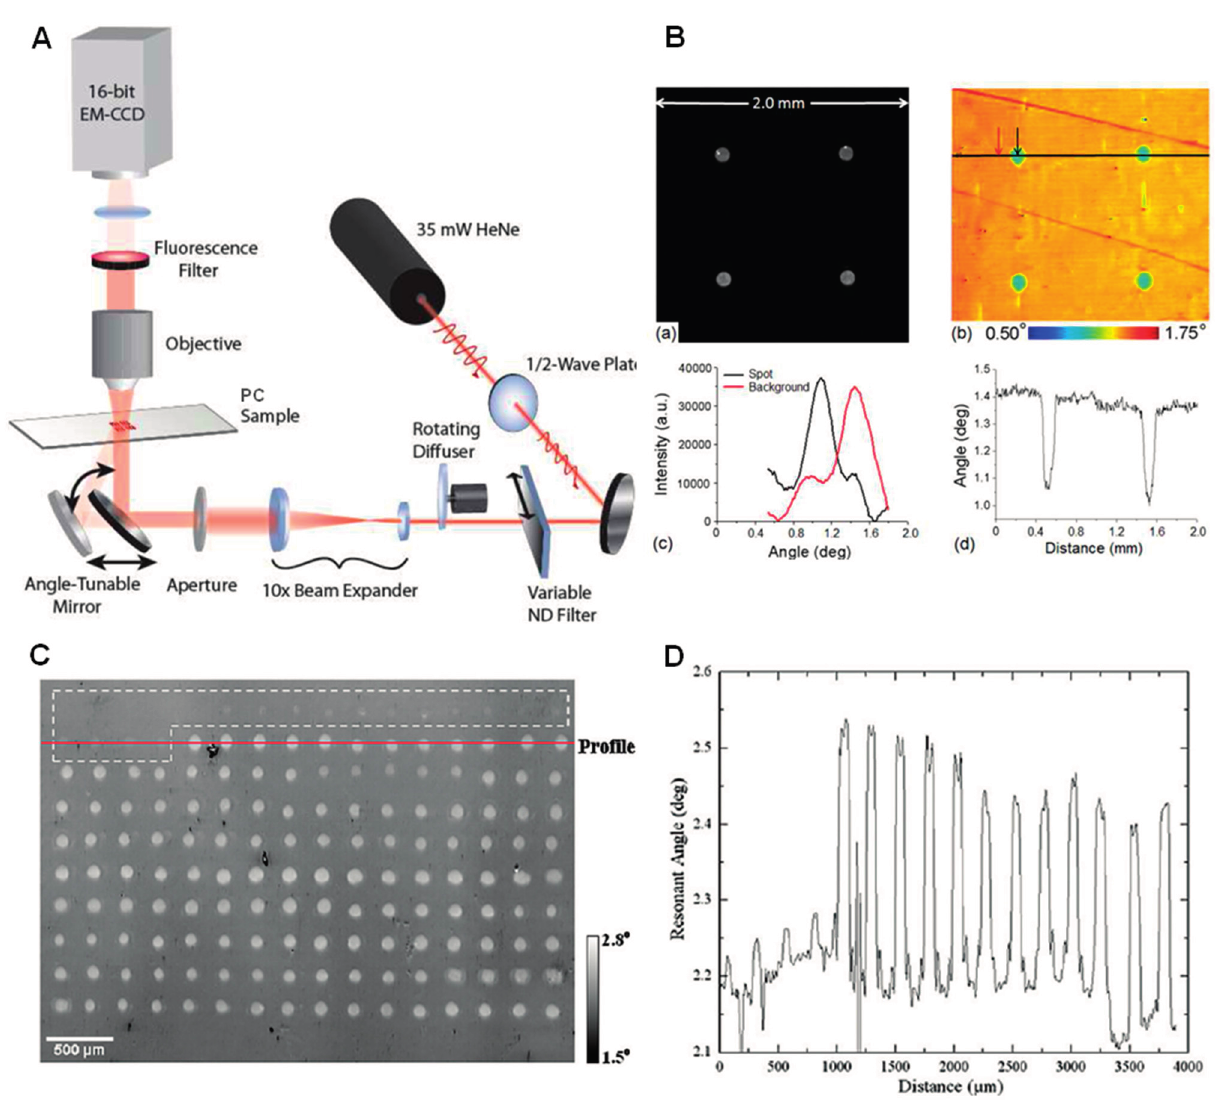
Figure 3. Instrument 2: Transmission acquisition mode of photonic crystal biosensor integrated with an upright imaging microscope and using laser as light source. ( A ) Schematic of combined label-free and enhanced-fluorescence imaging instrument; ( B ) Enhanced (a) fluorescence and (b) label-free images of 50 mg/mL SA-Cy5 spots on a PC biosensor. Inverted transmission versus angle response for a pixel inside and outside the SA-Cy5 spot in (c), and cross-section of the label-free image through two SA-Cy5 spots in (d). Rather than measuring the PWS, the label-free imaging system measures the angle of minimum transmission (AMT) by illuminating the PC sensor at a fixed wavelength while scanning the angle of illumination through computer-controlled rotation of the mirror (reprinted in part with permission from [76], © 2009 American Optical Society); ( C ) Label-free image of a DNA microarray measured with a PC biosensor. The white dashed box denotes the location of a set of 20 intentional blank spots. A line profile running through a row containing 4 blank spots followed by 12 probe spots is shown in ( D ) (Reprinted in part with permission from [37], © 2010 American Chemical